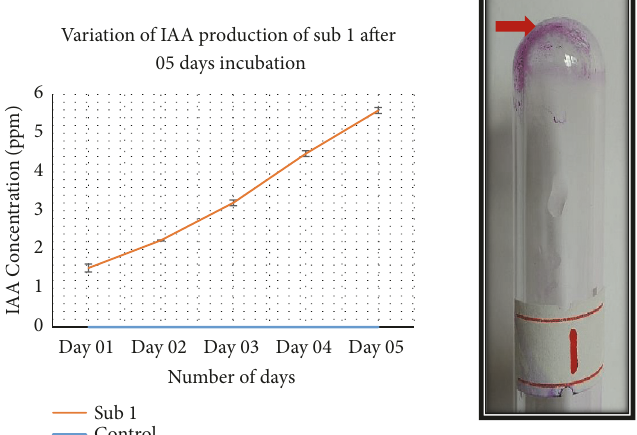
Figure 4: The development of purple color in tubes treated with crystal violet, indicative of biofilm formation (right), and the graph demonstrating the increase in IAA production in a period of 5 days by Sub1 cultures (left). The negative control of biofilm formation is provided in Supplementary Figure 5. Note : the control goes along the